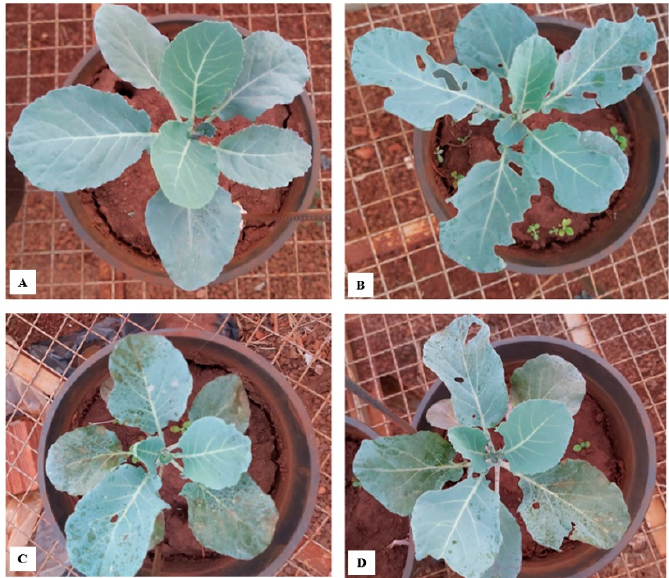
Figure 2. Overview of cabbages from different treatments. ( A ). Control sample unit and without Plutella xylostella infestation. ( B ). Sample unit, control infested. ( C ). Sampling unit with ETPM. ( D ). Sampling unit with ETPI.